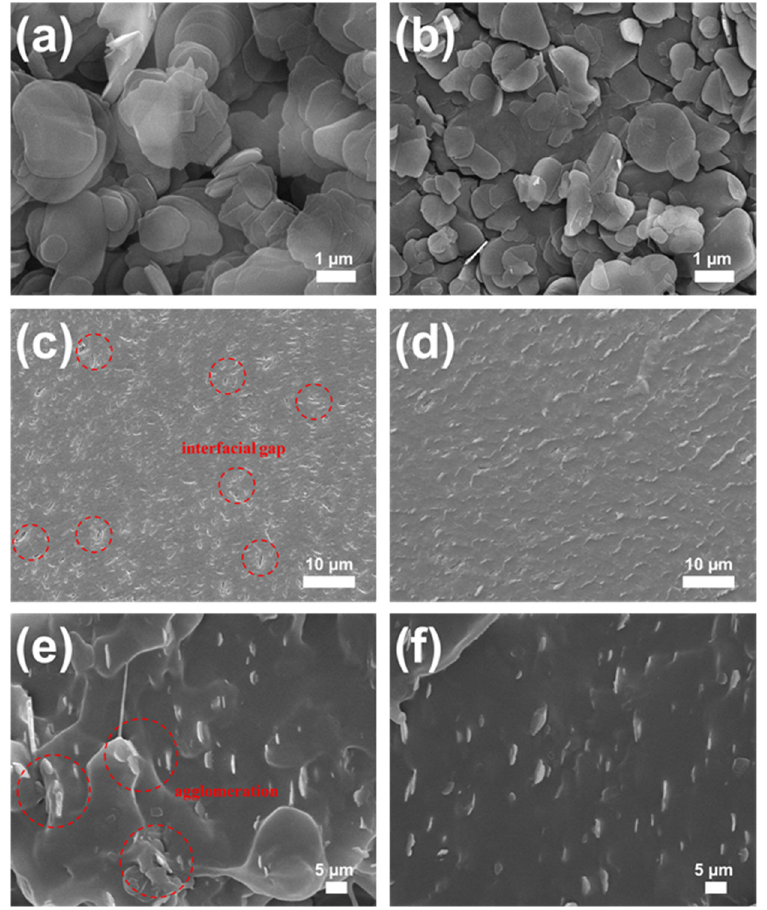
Figure 5. FE-SEM images of ( a ) h -BN and ( b ) OH-BN filler particles; ( c ) cross-sectional view of the h -BN/TPU and ( d ) OH-BN/TPU filaments; ( e ) the h -BN/TPU and ( f ) OH-BN/TPU composite cross-sectional morphologies. Each composite studied incorporated a 10 wt.% filler concentration.